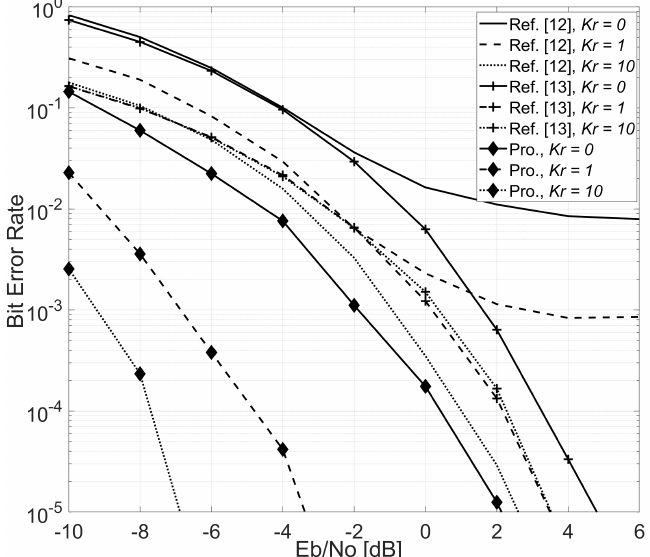
Figure 3. Performance comparison between the proposed 16-DQAM scheme and the previous works of References [12,13] under Rician fading with different Rician